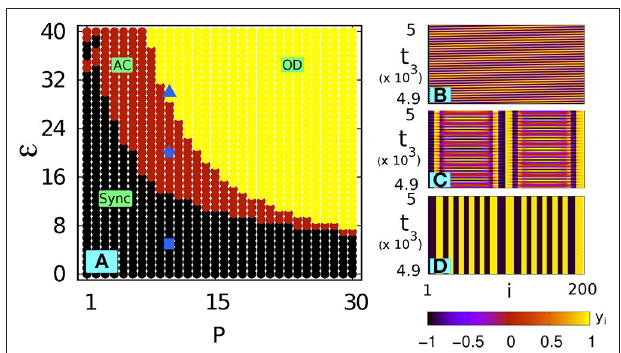
ε space for FIGURE 1 | Without filtering: (A) phase diagram in the P − N 200 nonlocally coupled Stuart-Landau oscillators ( ω 2). Sync, = = synhronized state; AC, amplitude chimera; OD, oscillation death. (B–D) The spatiotemporal plots at P 10 for three different coupling strengths ε : (B) = synchronized state for ε 5 [shown by (cid:4) in (A) ], (C) AC for ε 20 [shown by = = ⋆ in (A) ] and (D) multicluster OD for ε 30 [shown in N in (A) ]. =